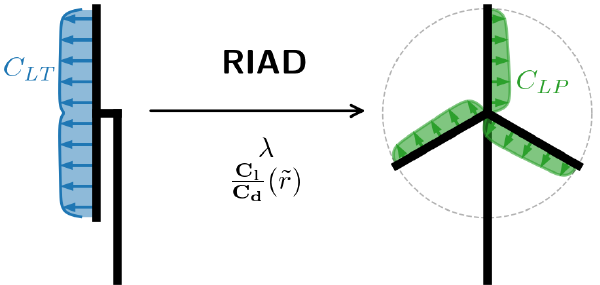
Figure 1. Diagram showing a diagram for the Radially Independent Actuator Disc (RIAD)